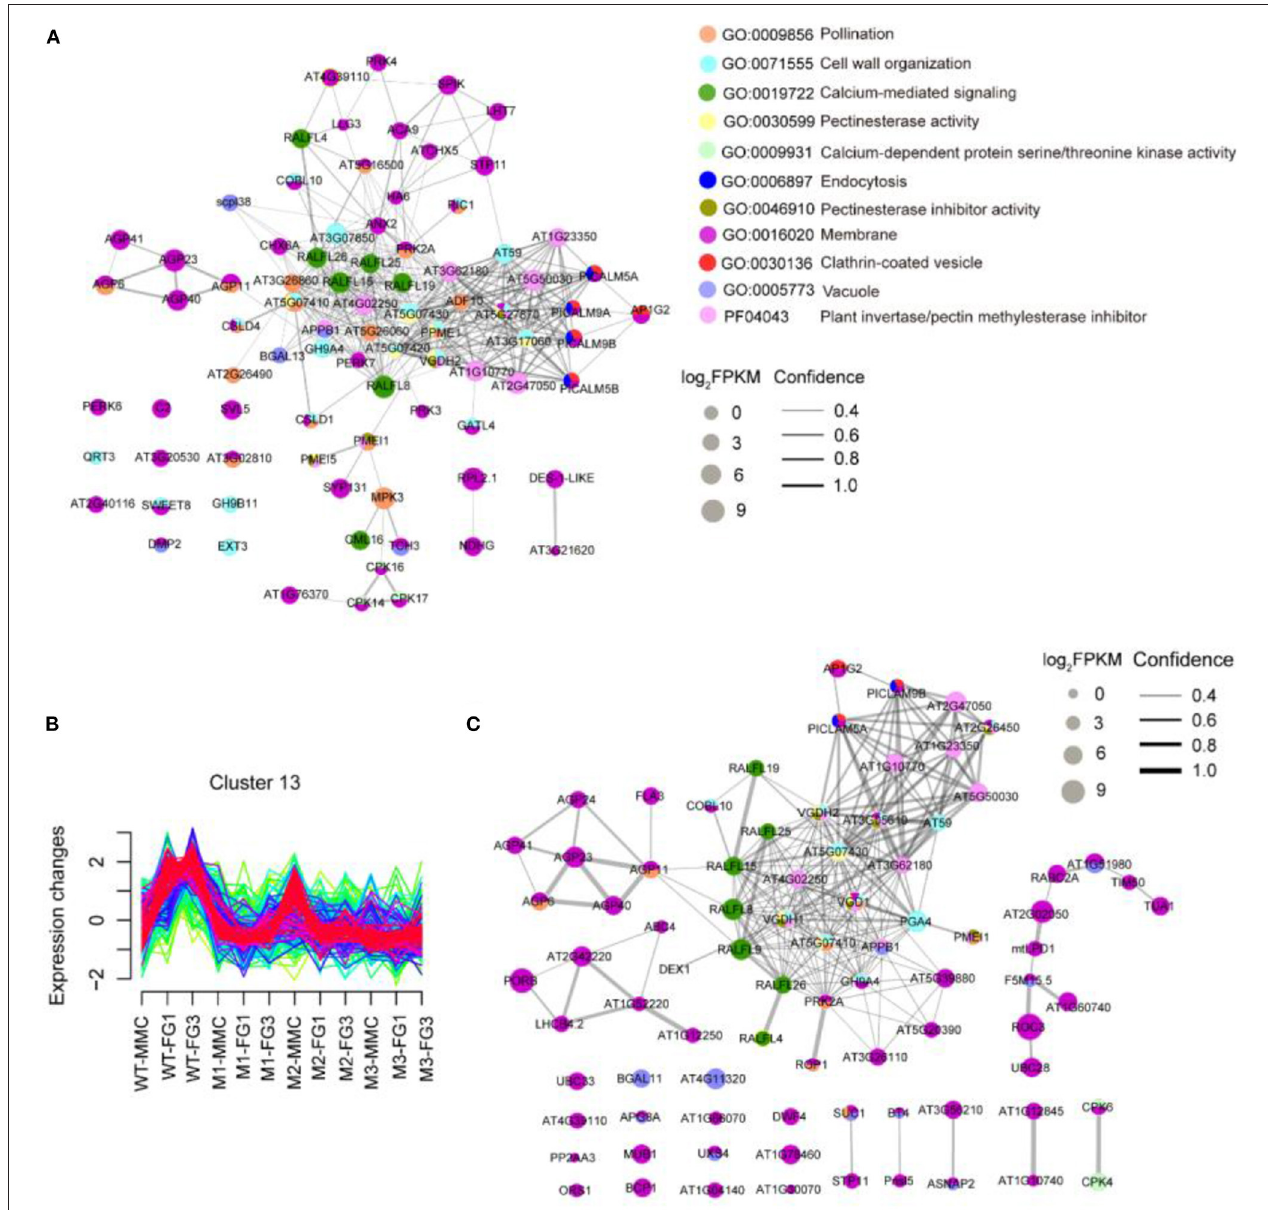
FIGURE 6 | STRING protein-protein interaction network. (A) The STRING analysis downregulated DEGs of ap1g2-1 + / − . (B) Cluster 13 showed an increase of the expression level at FG1 in wild-type ovules but repressed in the ap1g2 mutants at various stages. The y axis represented the standardized FPKM value of genes, and the x axis represented the different samples. (C) Genes of Cluster 13 that were enriched on the above GO terms in (A) were used for STRING analysis. Colored nodes from (A,C) indicated the proteins enriched on different GO terms. The size of each node indicated the normalized FPKM value. Lines between nodes represented both functional and physical protein associations. The line thickness indicated the confidence of